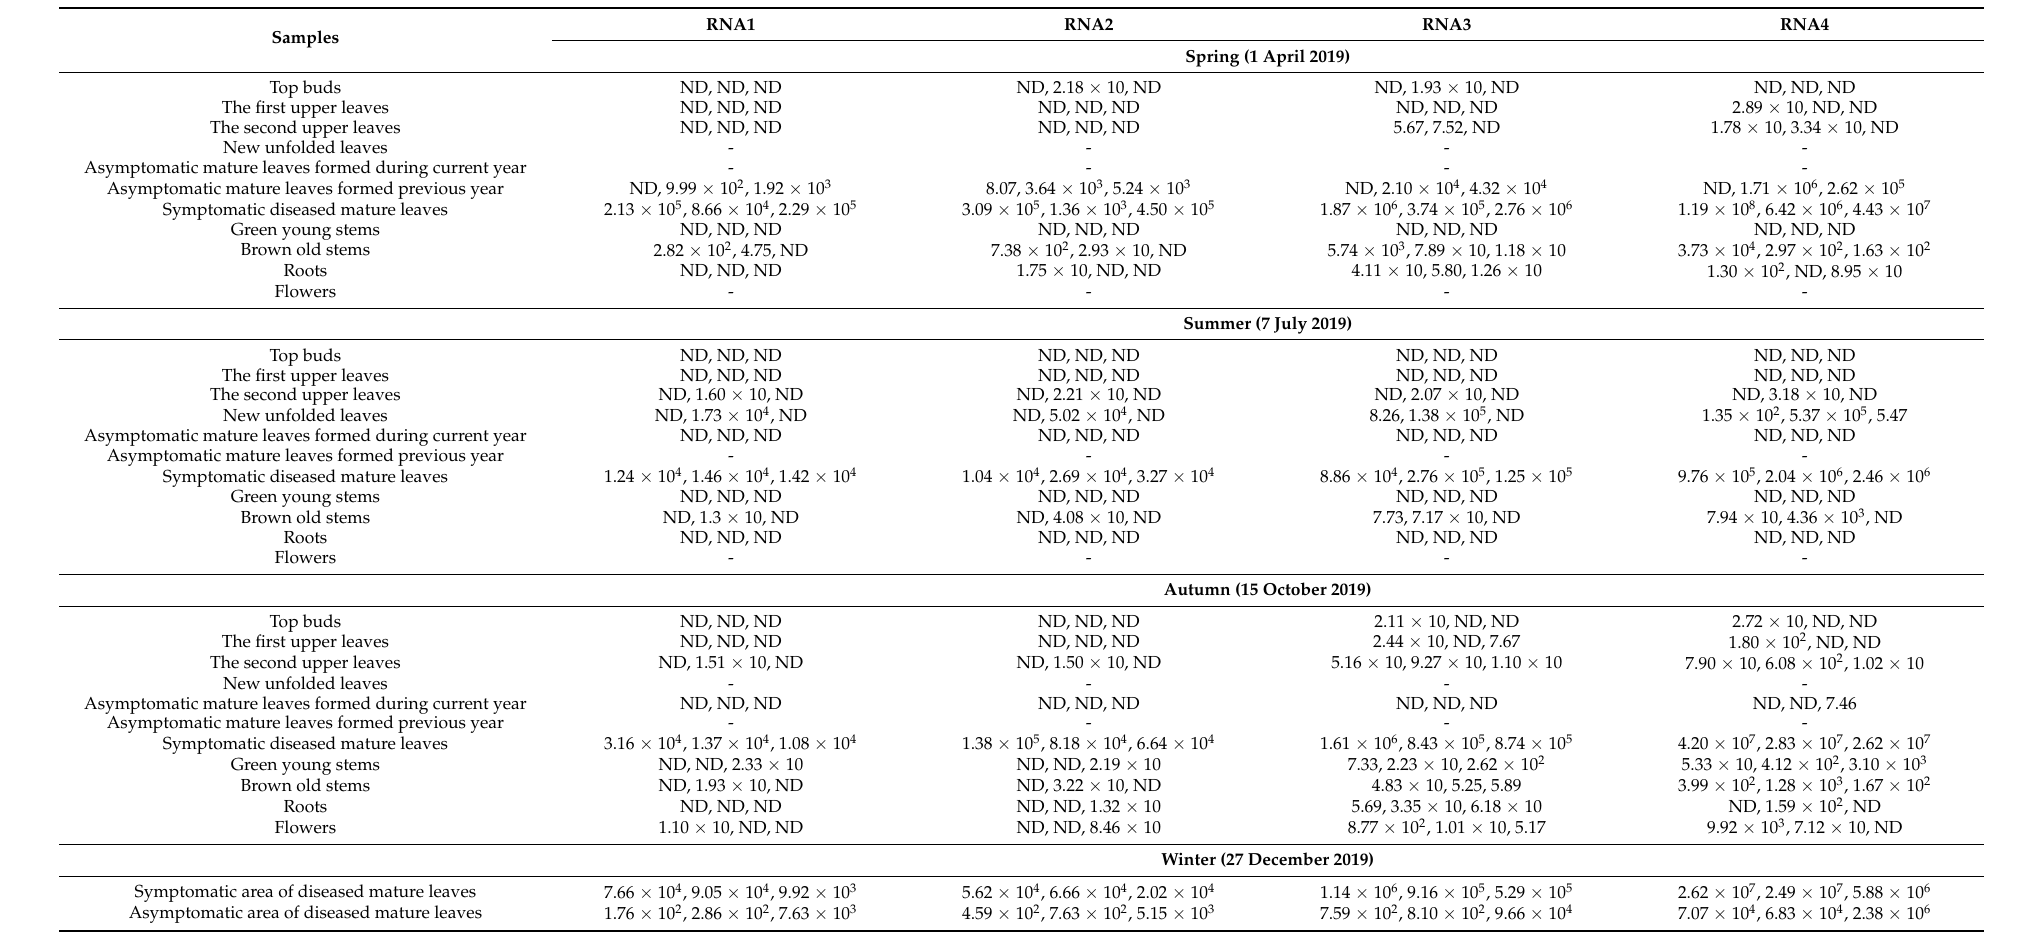
Table 1. Detection of TPNRBV in different tissues of diseased ‘Baiye 1’ (BY 1).